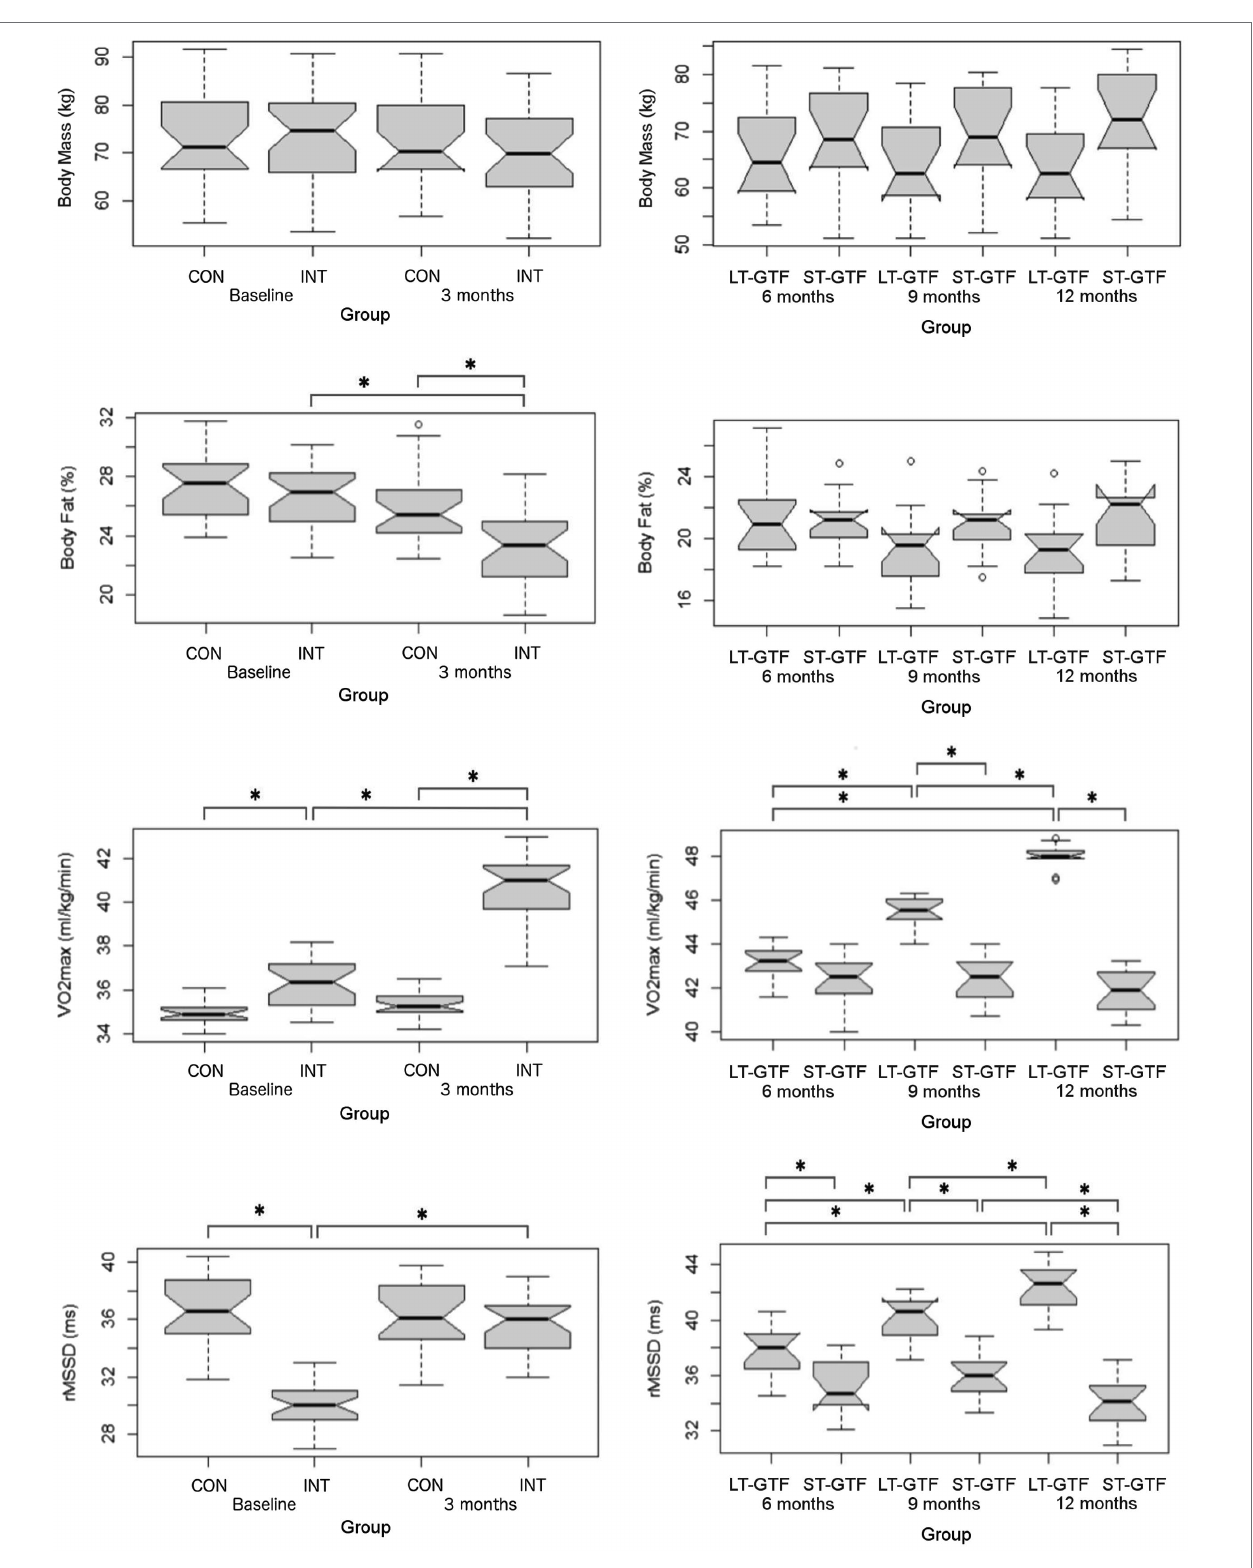
FIGURE 3 | Anthropometrics (Body Mass, BF%), cardiovascular fitness (VO 2 max), and autonomous nervous system (rMSSD) data. Graphs on the left represent control (CON) and intervention (INT) groups from baseline to month 3. Graphs on the right represent measurements taken at 6, 9, and 12 months. LT-GTF, Long- term GTF group; ST-GTF, Short-term GTF. * Represent statistically significant